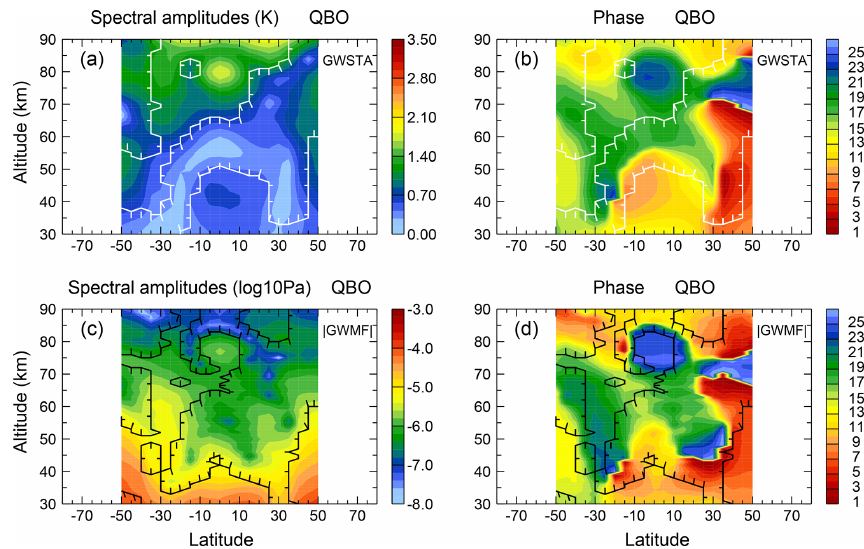
Figure 7. Same as Fig. 2, but for the QBO. The phase (b, d) color codes are in the number